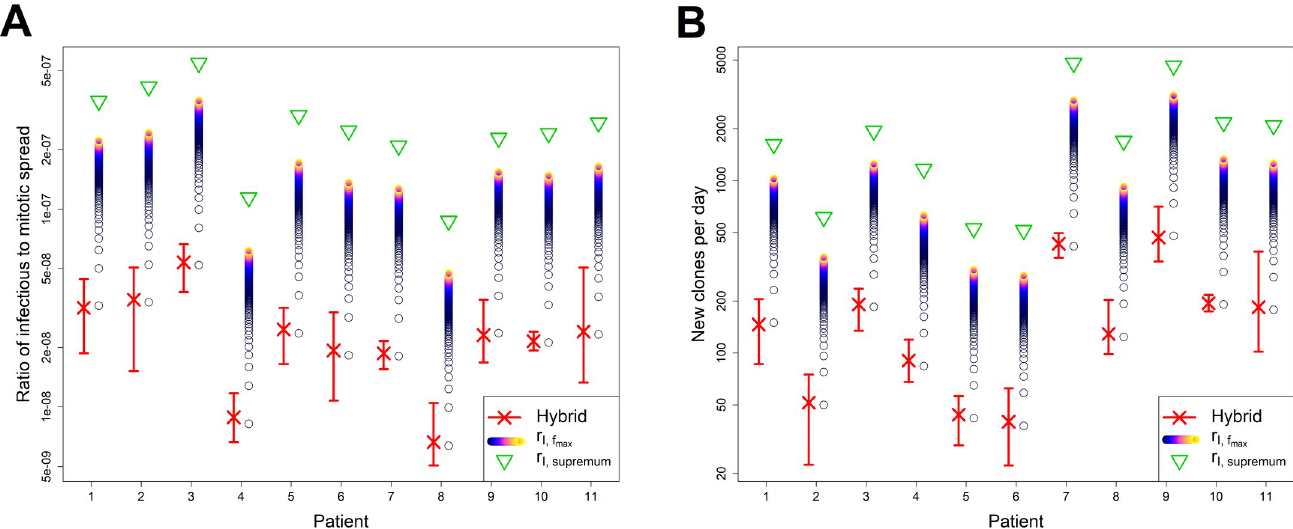
Fig 5. Ratio of infectious spread to mitotic spread and number of new clones per day, by patient and estimator. A Ratio of infectious spread to mitotic spread. B Number of new clones generated per day. Values of both the ratio and number of new clones are derived from estimators of infectious spread. In each plot, red crosses and bars respectively denote point estimates and the range from the nine estimates for each subject from the hybrid model. Upper bound approximations from r I , Supremum (green triangles) are shown, together with tighter upper bounds from r (coloured circles) for multiple values of f max between 1 and 1000. Lighter I ; f max colours denote higher values of f max . Hybrid model point estimates are very close to the estimates obtained for f max = 1 (lowest circles). Estimates plotted on logarithmic scale.